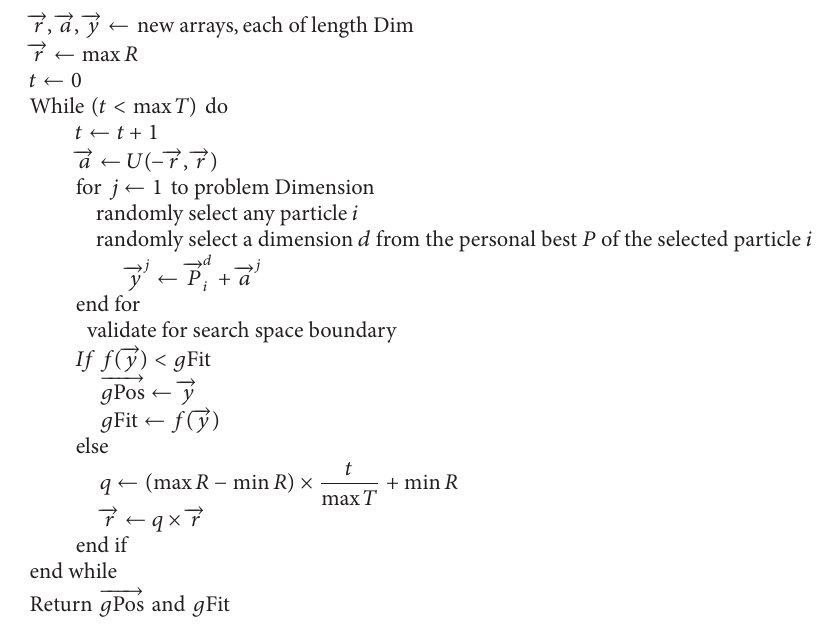
Algorithm 1: Collective local unimodal search.